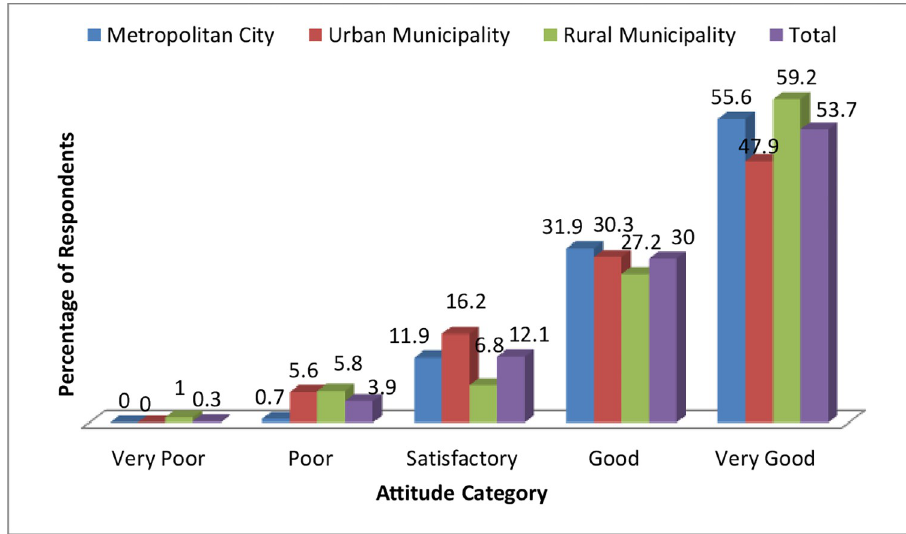
Fig 3. Level of student’s attitude score on diabetes and